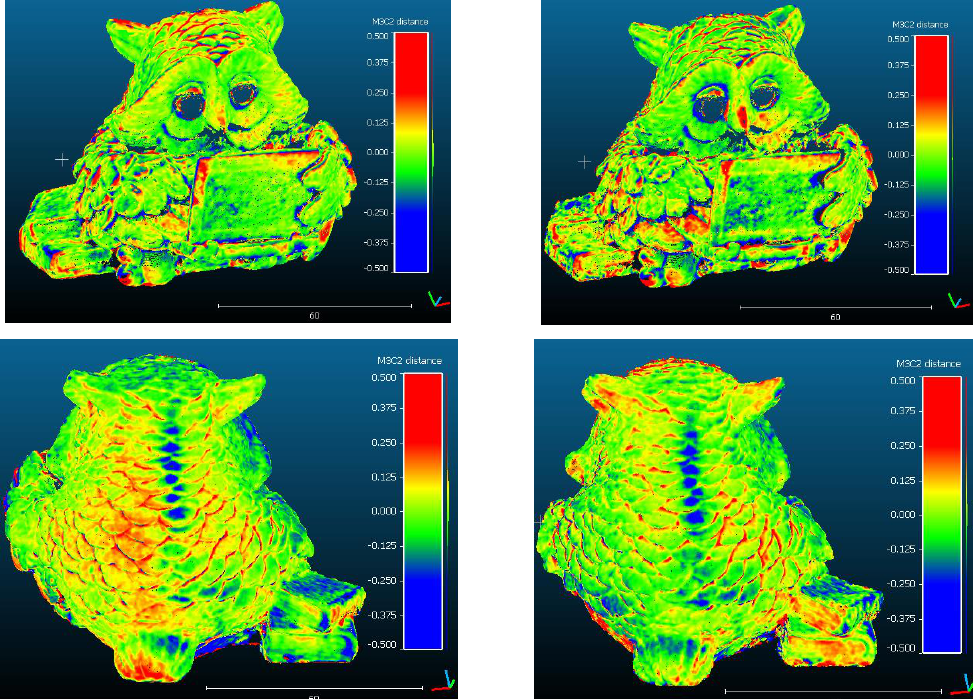
Figure 12: Comparisons with the M3C2 algorithm real part of the object (left) and the reflection